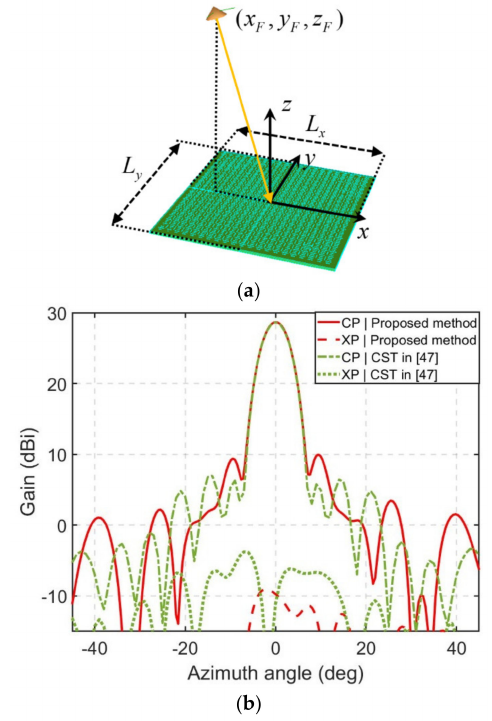
Figure 10. ( a ) Focused beam reflectarray made of two sets of four parallel dipoles with small rotations. ( b ) Co-polar and cross-polar radiation patterns in azimuth plane for X-polarization at 11.95 GHz. Numerical results obtained with the proposed method for 4096 × 4096 equi-spaced mesh and CST results given in [47] are